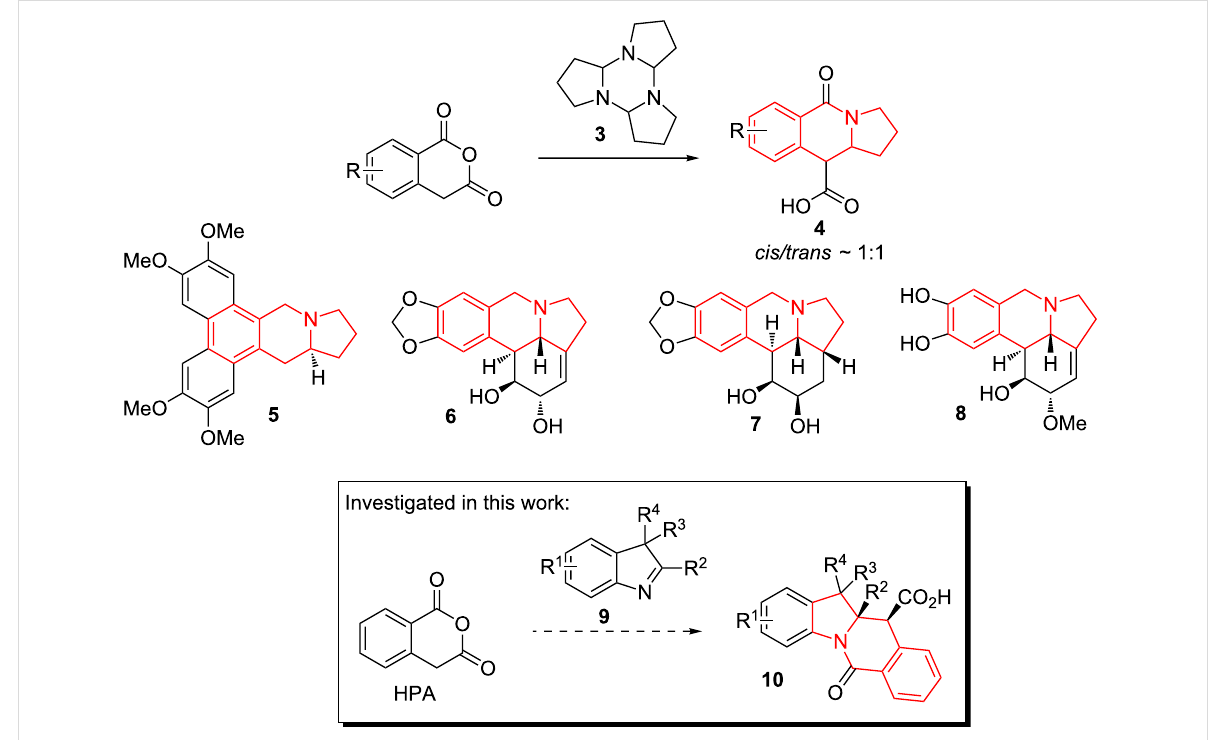
Figure 2: Assembly of hexahydropyrrolo[1,2- b ]isoquinoline core via the CCR and its occurrence in natural and synthetic bioactive compounds.